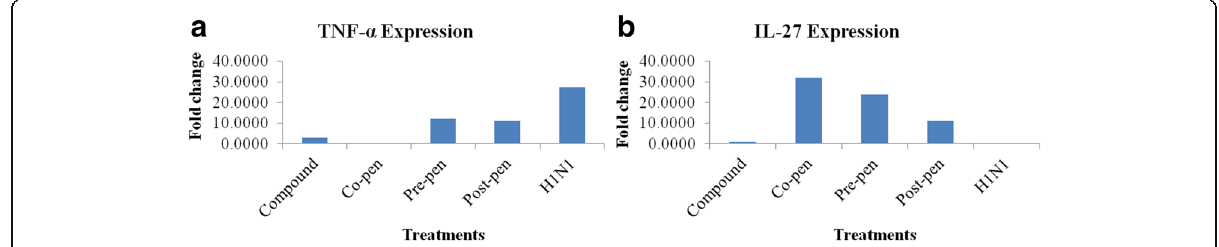
Fig. 5 Relative expression analysis ( ΔΔ Cq) of the cytokines TNF- α ( a ) and IL-27 ( b ) compared to the positive control